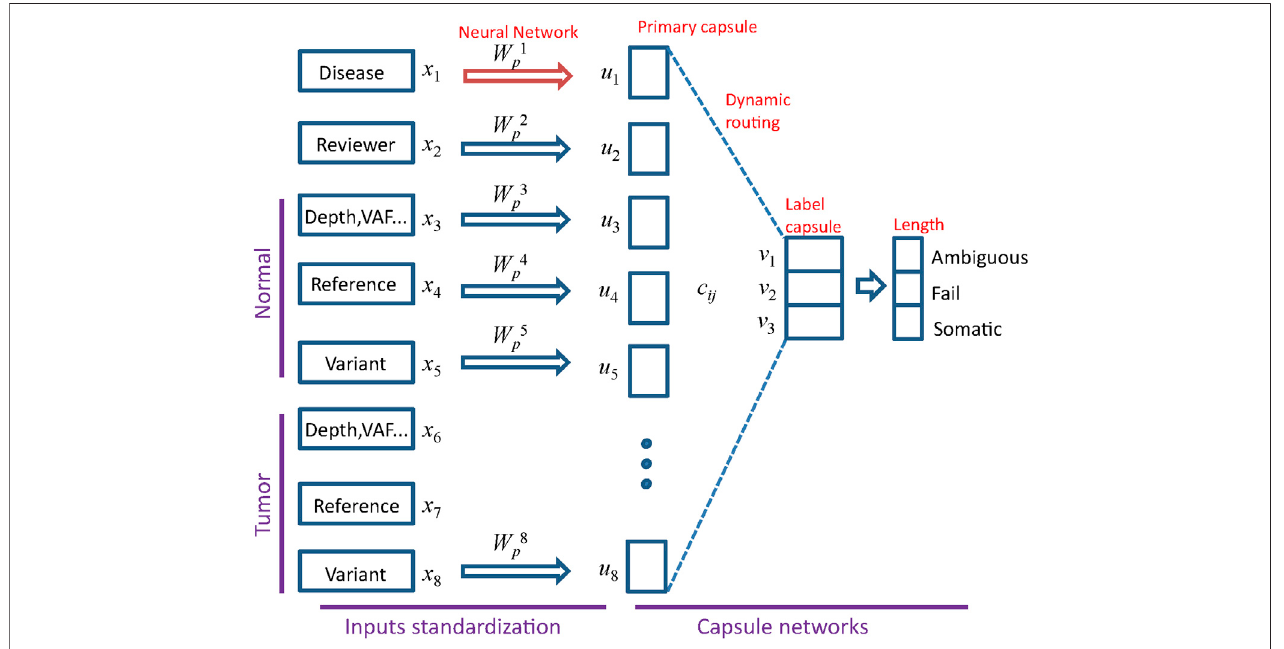
FIGURE 2 | Architecture of MultiCapsNet with two layers. The fi rst layer consists of eight parallel neural networks, corresponding to eight data sources (groups). The outputs of neural networks are the primary capsules (real valued vectors) with equal length. The second layer is the Keras implementation of CapsNet for classi fi cation. The length of each label capsule represents the probability that the input data belongs to the corresponding classi fi cation category.